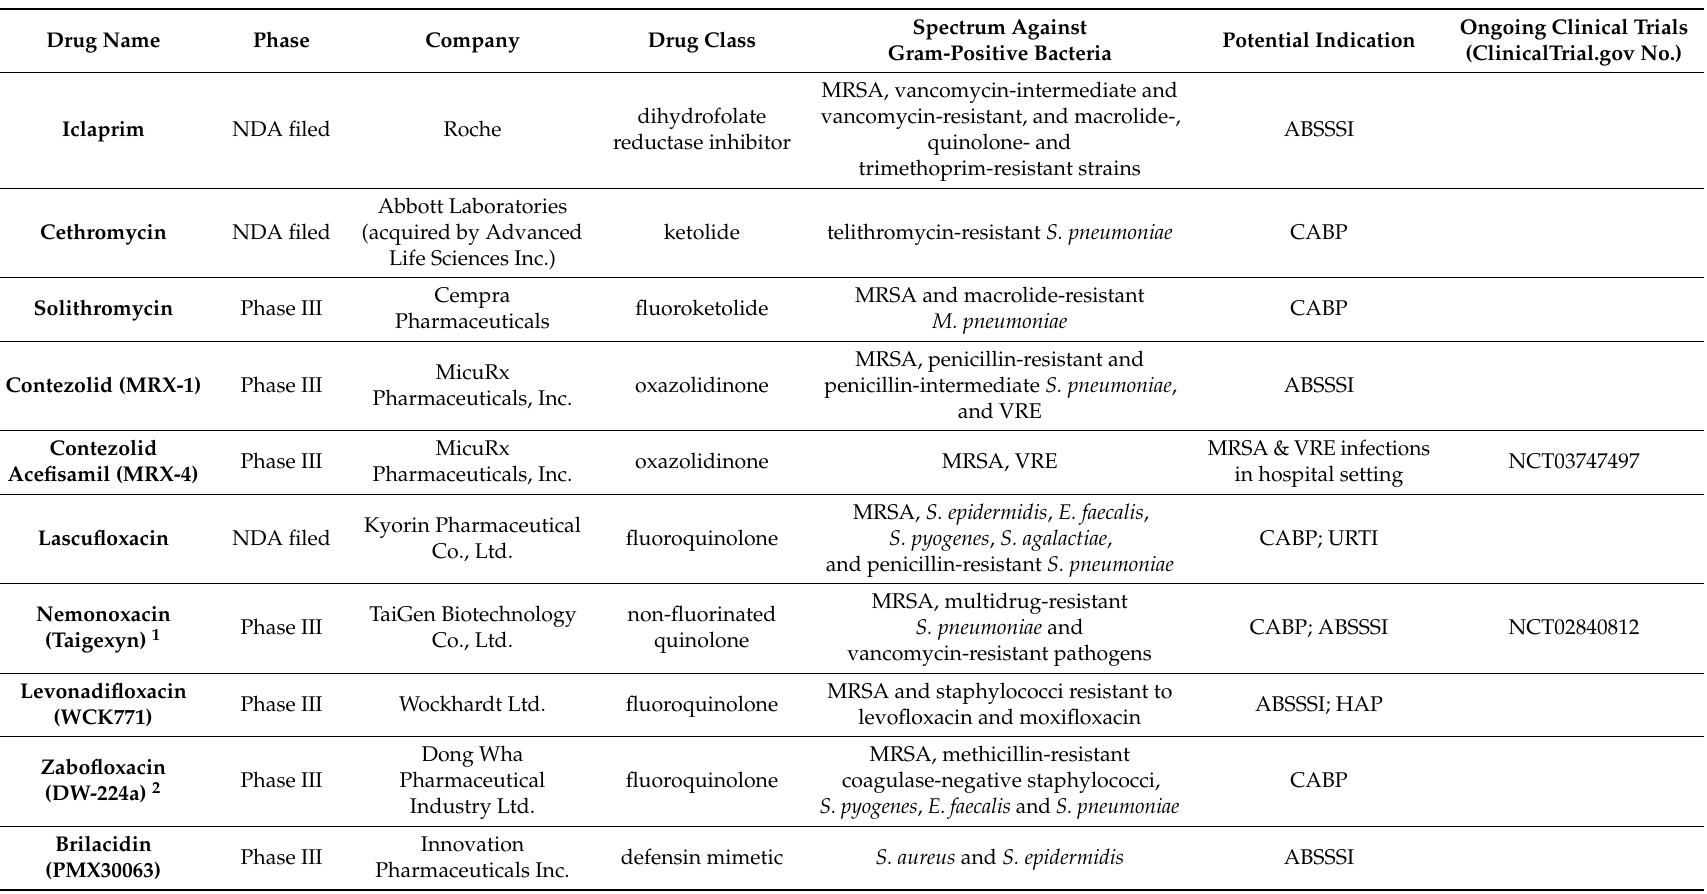
Table 1. Summary of antibiotics with activity against Gram-positive bacteria with New Drug Application (NDA) filed or are currently in Phase III clinical